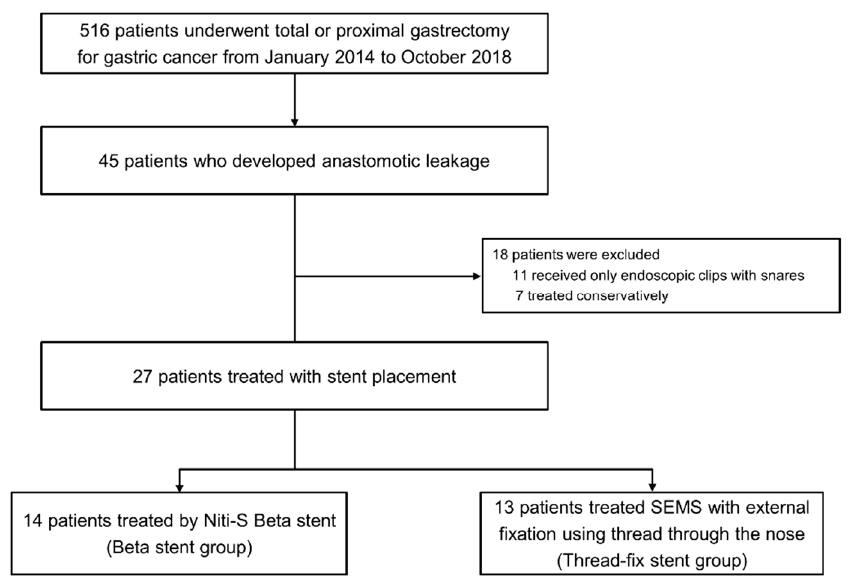
Figure 2. Patient inclusion flowchart.